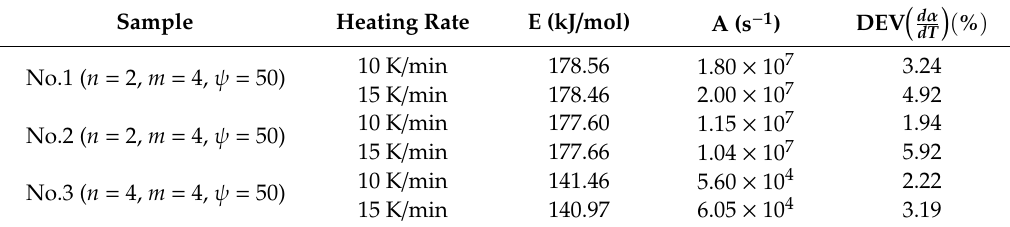
Table 3. Kinetic parameters under di ff erent heating